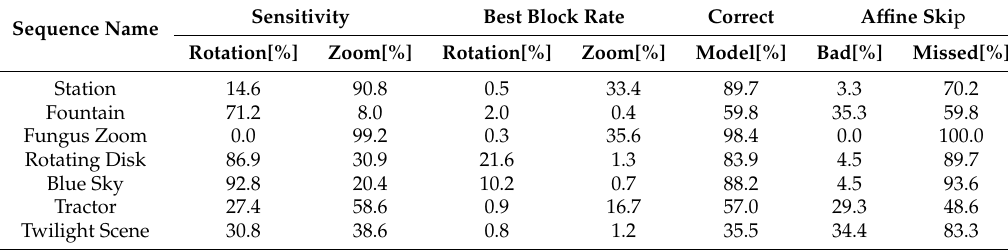
Table 2. Evaluation of mode prediction accuracy of the proposed method compared to Reference